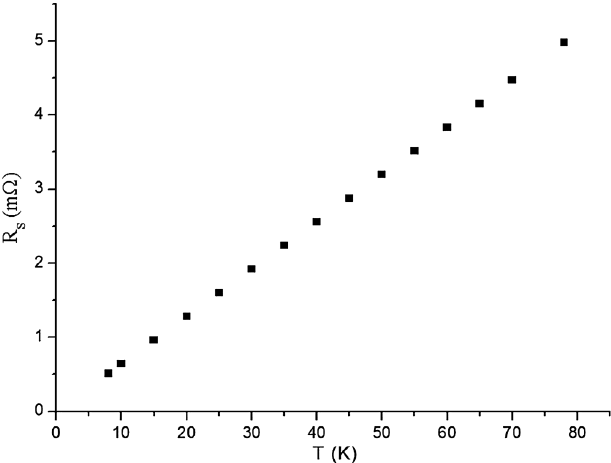
FIG. 5. 172.5 MHz half wave cavity normal state region sur- face resistance ( RRR ¼ 250 ).